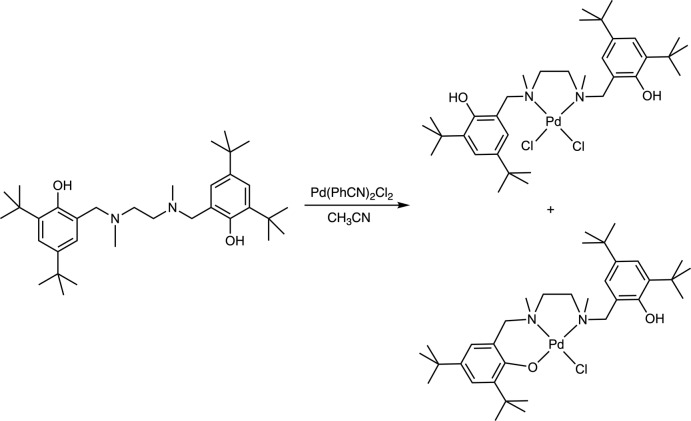
Preparation of κ2 and κ3 amine bis­(phenolate) PdII complexes.